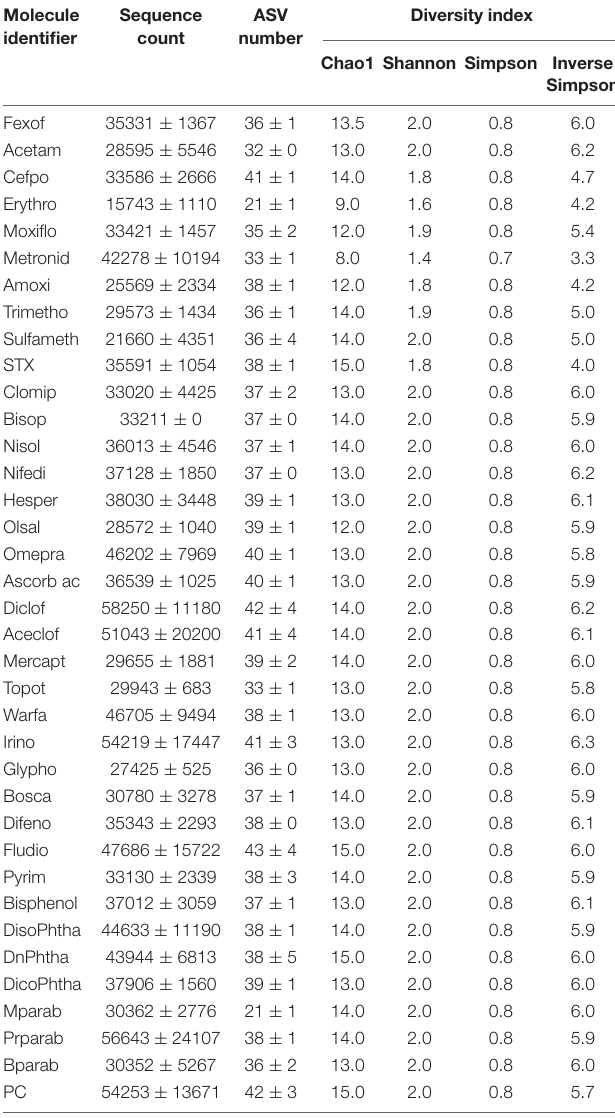
TABLE 3 | Number of sequences of amplicon sequence variants, and diversity index for experiments with molecules and the positive